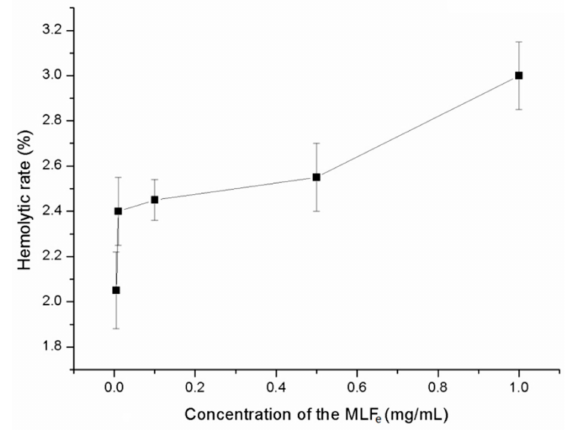
Figure 5. Hemolysis analysis of MLF e